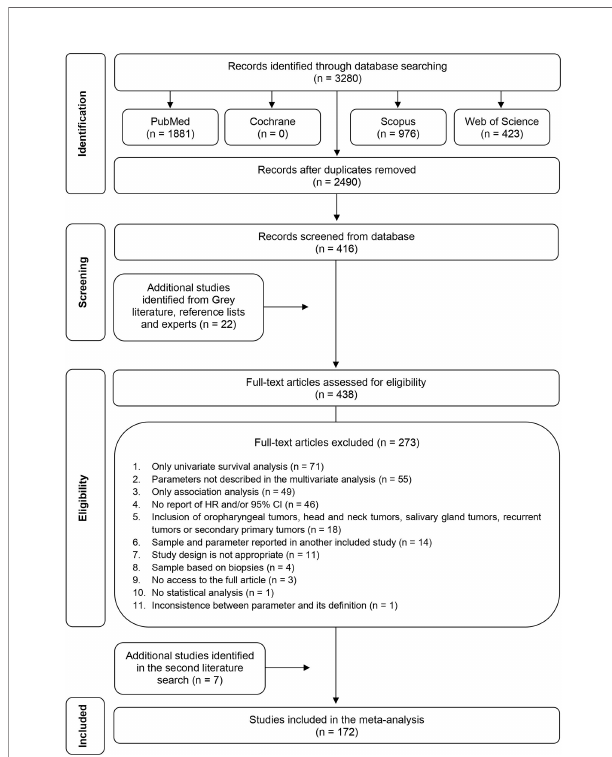
FIGURE 1 | PRISMA fl ow diagram of literature search and selection criteria applied in this